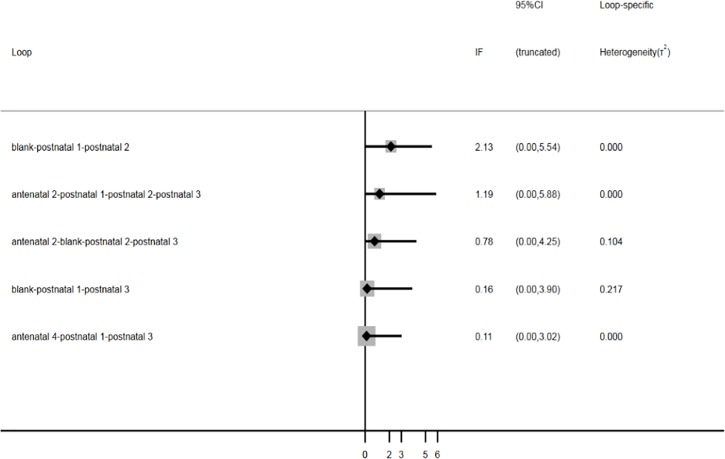
Inconsistency test.